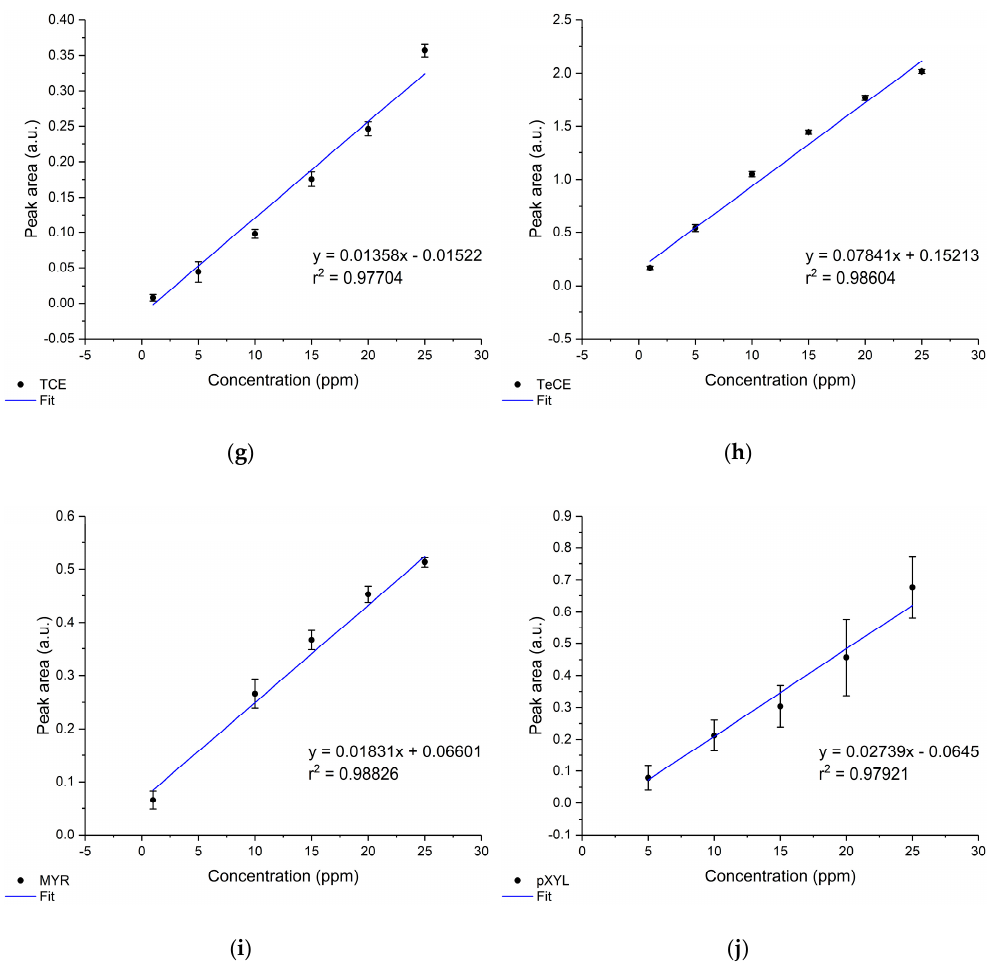
Figure 7. Established calibration functions of the simultaneously determined volatile organic compounds (VOCs) in seawater by the developed MIR chemical sensor. The concentration ranged from 1 to 25 ppm. Data points were obtained by peak area integration. ( a ) 13DCB, ( b ) pCYM, ( c ) EB, ( d ) 12DCB, ( e ) 124TCB, ( f ) CAR, ( g ) TCE, ( h ) TeCE, ( i ) MYR, and ( j ) pXYL. All obtained linear fits resulted in 𝑟 (cid:2870) -values (goodness of the fit) greater than 0.97. For 12DCB, 124TCB, and CAR, the 𝑟 (cid:2870) -value was even higher than 0.999. The limit of detection (LOD) and limit